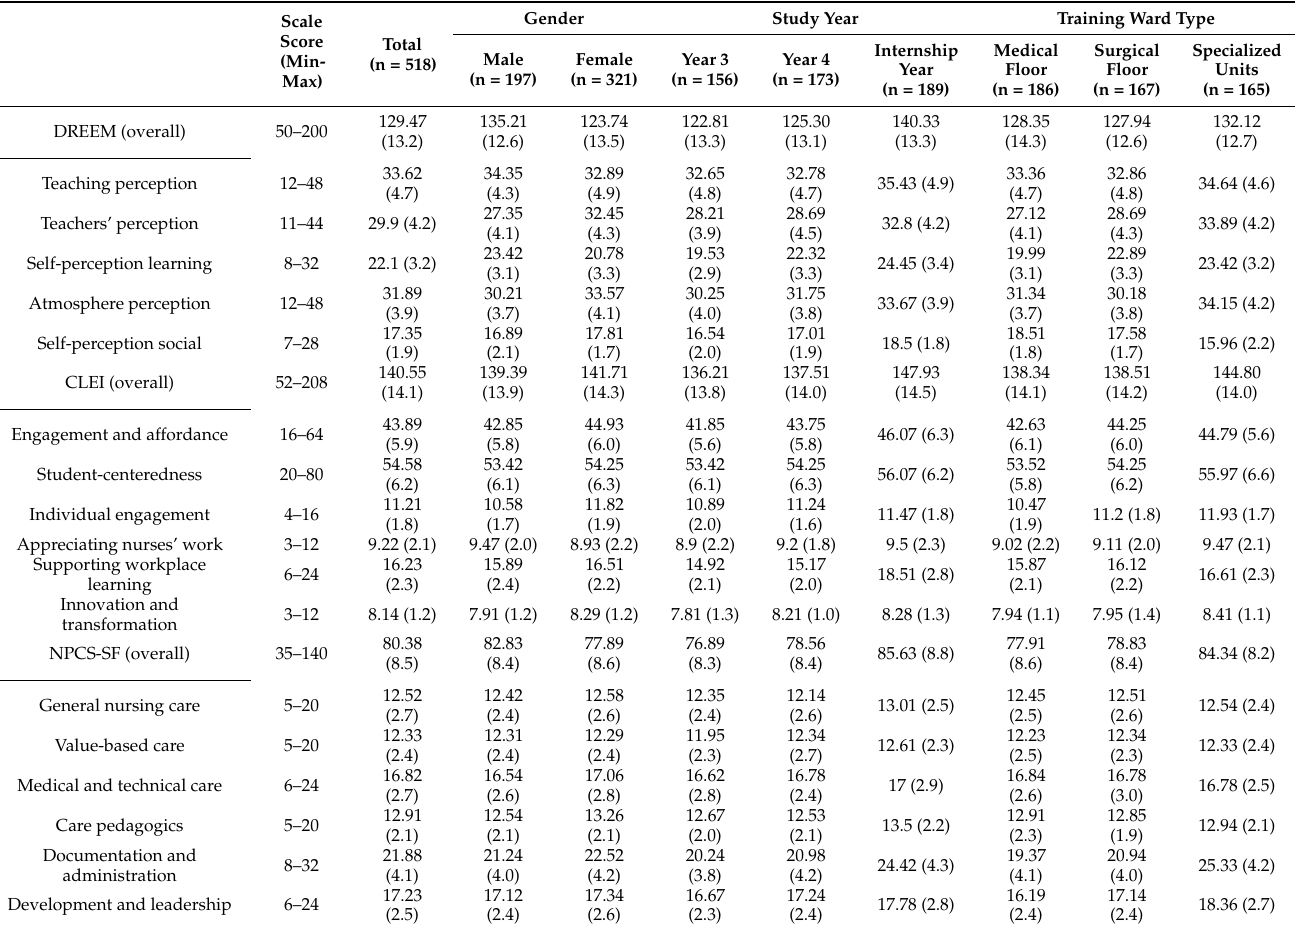
Table 2. The participants’ overall mean total score for DREEM, CLEI, and NPCS-SF subscales by gender, study year, and training ward type (n =